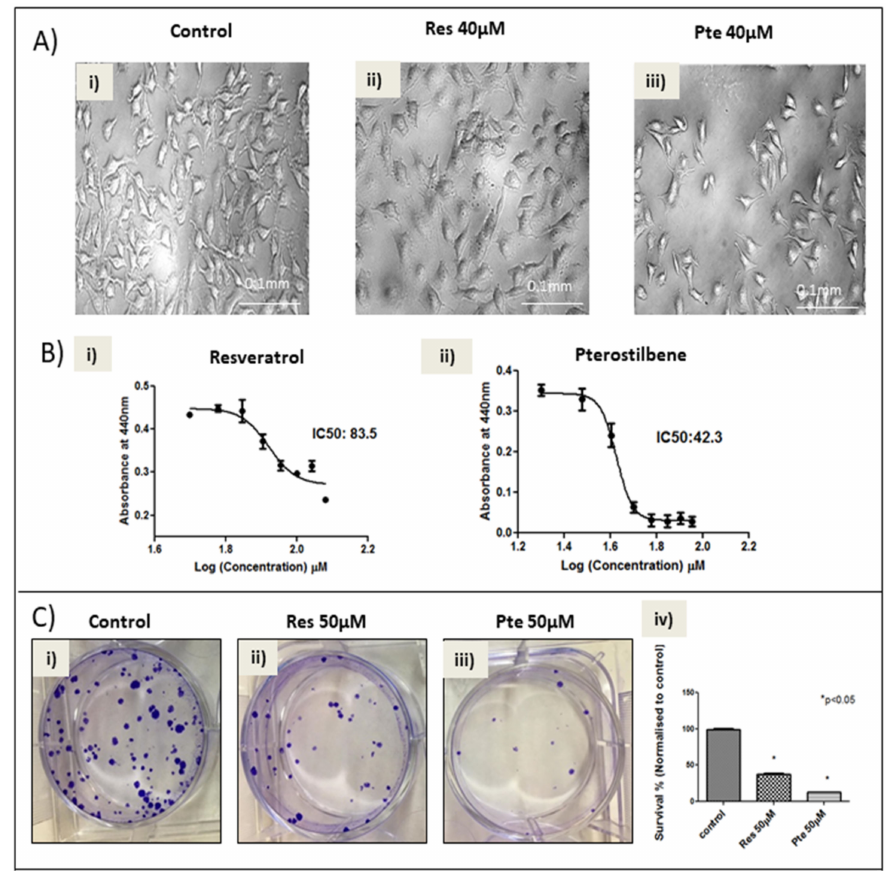
Figure 1. Pterostilbene is more potent in eliminating HeLa cervical cancer cells as compared to resveratrol: ( A ) Brightfield analysis of HeLa cells untreated (Ai) or treated for 24 h with 40 µ M of resveratrol (Res; Aii) or 40 µ M of pterostilbene (Pte; Aiii). Evidence of cell elimination was only seen robustly in cells treated with pterostilbene at 40 µ M. ( B ) Analysis of IC 50 values, generated by a Water Soluble Tetrazolium salt-1 (WST-1) assay after 24 h of exposure to resveratrol or pterostilbene indicates that pterostilbene (IC 50 = 42.3 µ M) is a more potent cytotoxic agent than resveratrol (IC 50 = 83.5 µ M; Bii). The graphs represent data from three independent experiments (mean ± S.E.M. (Standard error mean)). ( C ) Clonogenic assays performed to compare the relative effect of the two polyphenols on the clonogenicity of HeLa cells untreated (Ci) or treated with 50 µ M of either resveratrol (Cii) or pterostilbene (Ciii). Results are from 15-days post-treatment and indicate that pterostilbene is more efficient in curbing the clonogenicity compared to resveratrol (Civ). Bar graph represents data from three independent experiments (mean ± S.E.M.; * p < 0.05;